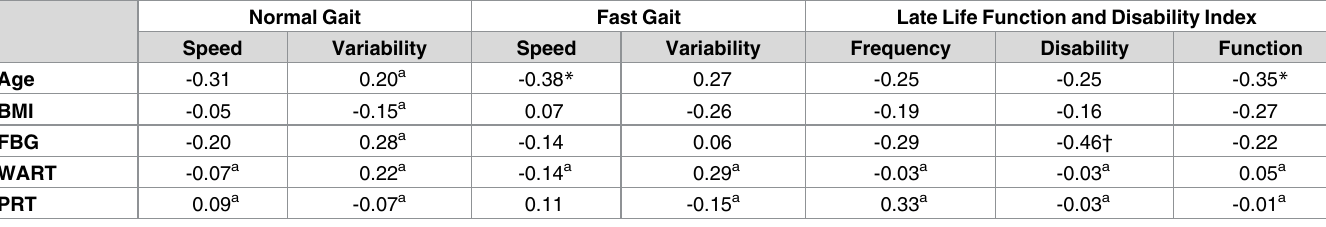
Table 4. Multitasking and other correlatesof gait and functional ability in subjects with diabetes.